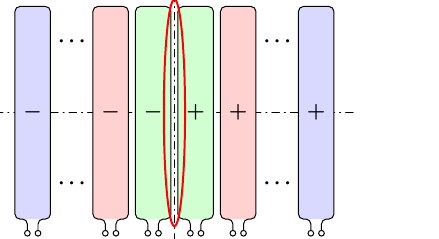
Figure 17. Compensation of areas where a sensor coil can be symmetrically stimulated by a foreign object (red markings)—the signs symbolize the orientation of the conductor loops, the colors the different sensor coils ( left ) Symmetrical arrangement of sensor coils in the second spatial direction based on Figure 16e ( right ) Asymmetrical arrangement of the two sensor coils close to the symmetry axis of the second spatial direction as proposed in